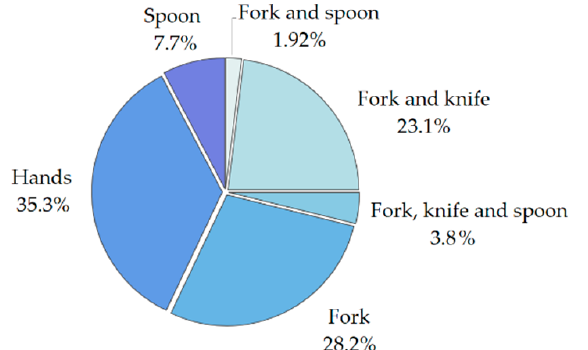
Figure 1. Distribution of the cutlery used for the recorded meals.